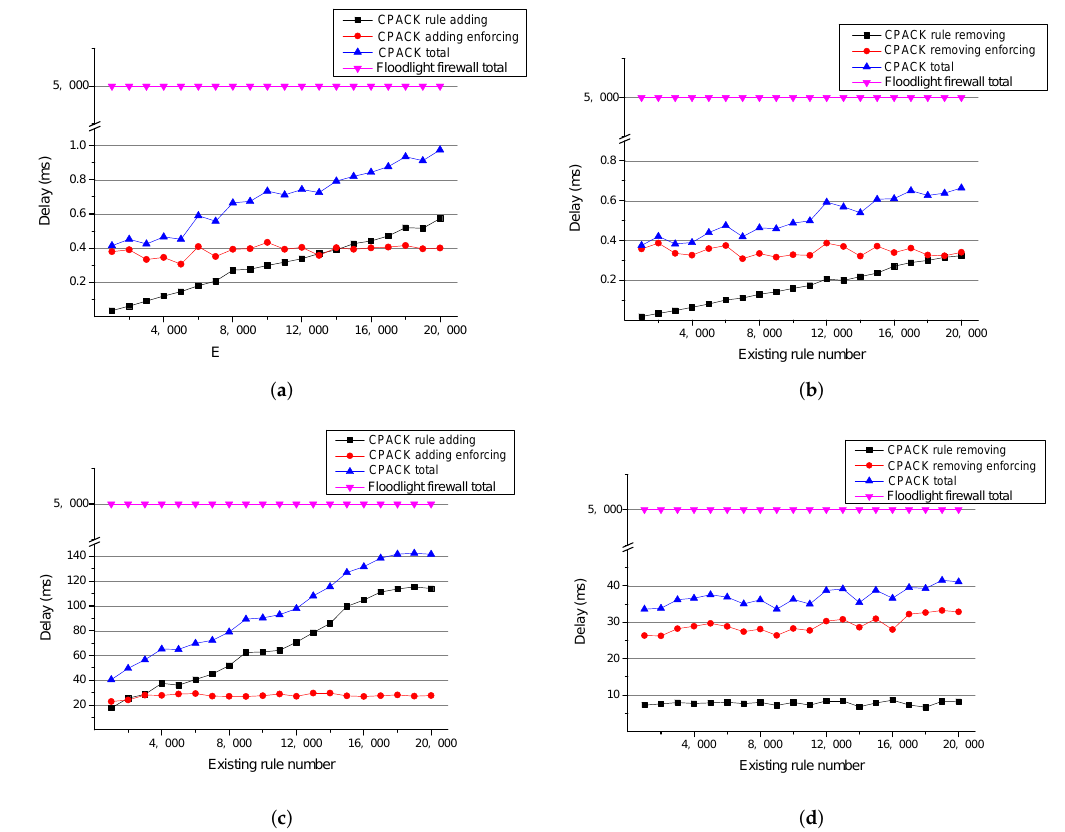
Figure 5. ACL update delay comparison. ( a ) Add a new ACL rule (single-controller version); ( b ) Remove an existing ACL rule (single-controller version); ( c ) Add a new ACL rule (multi-controller version); ( d ) Remove an existing ACL rule (multi-controller version).